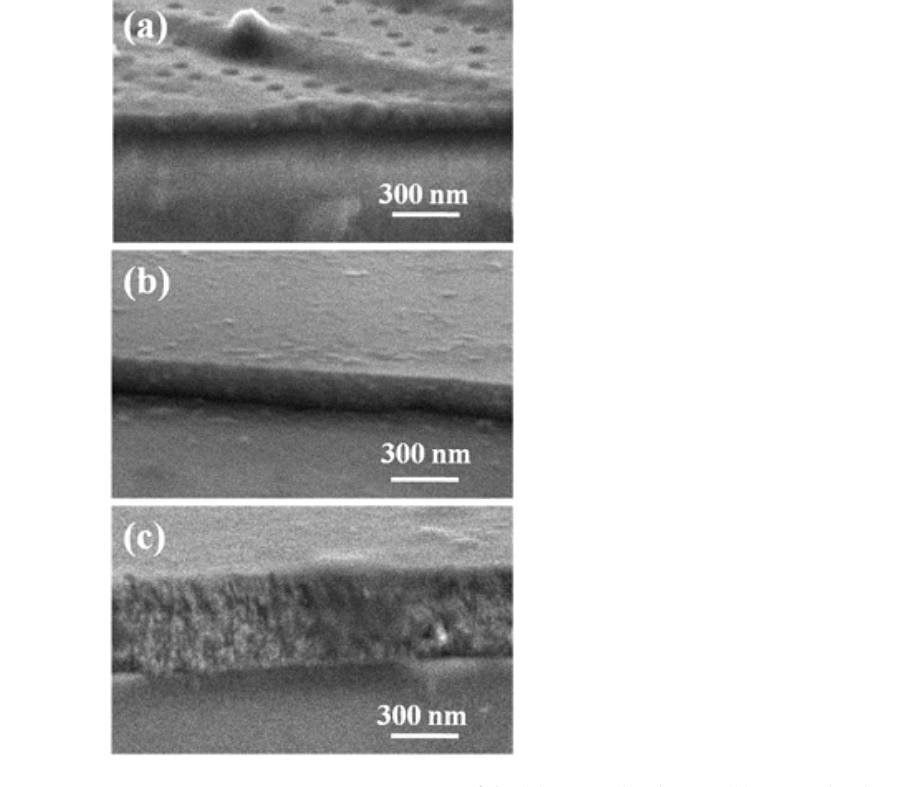
Figure 18. SEM cross-section images of the ( a ) TiO 2 :Nb-2 layers, ( b ) TiO 2 :Nb-5 layers, and ( c ) TiO 2 :Nb-20 layers films, from Ref. [89].